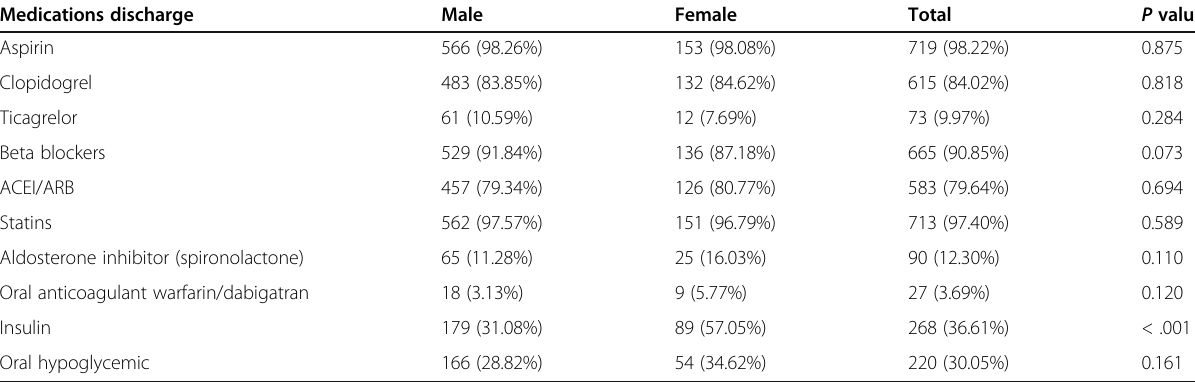
Table 3 Medication at discharge